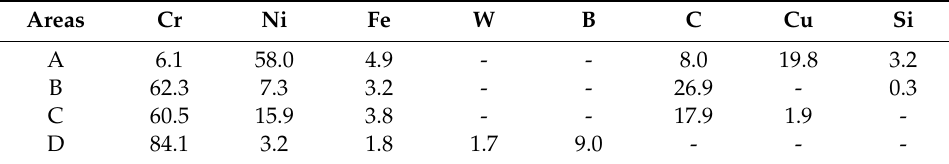
Figure 5. SEM image of the Ni–Co binding region microstructure. Table 3. Chemical composition of four areas in the Ni–Co transition coating (wt.%).